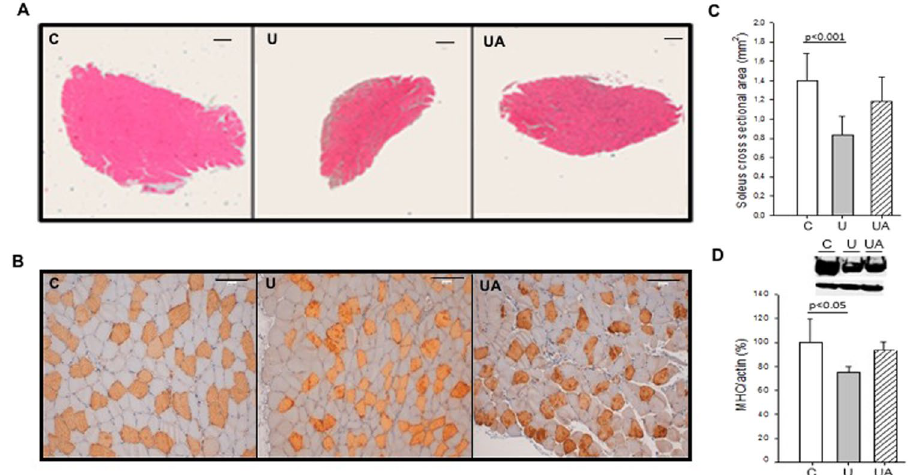
Figure 1. Allopurinol-treated mice are partially protected against hindlimb unloading-induced skeletal muscle atrophy. ( A ) Hematoxylin and eosin staining (Original magnification, 4 × . Scale bar, 100.00 µ m). ( B ) Myosin staining specific of MHC (type I fibers were deeply stained, while type II were lightly stained. Original magnification 20 × . Scale bar, 100.00 µ m). ( C ) Shows quantitative analysis of the cross-sectional area of the soleus muscle. ( D ) Representative western blotting and densitometric analysis of soleus MHC I (full-length blots are included in supplementary information. See Supplementary Figure 1). Actin was used as a loading control. Data are shown as mean ± SD. C = Control (n = 5–7); U = Unloading (n = 5–7); UA = Unloading treated with allopurinol (n =